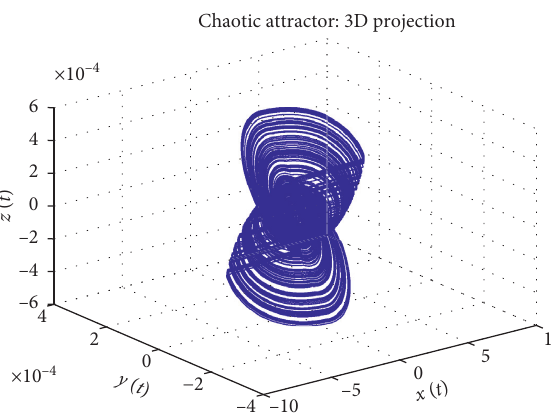
Figure 5: Chaotic attractor in the three-dimensional space based on the encryption method.